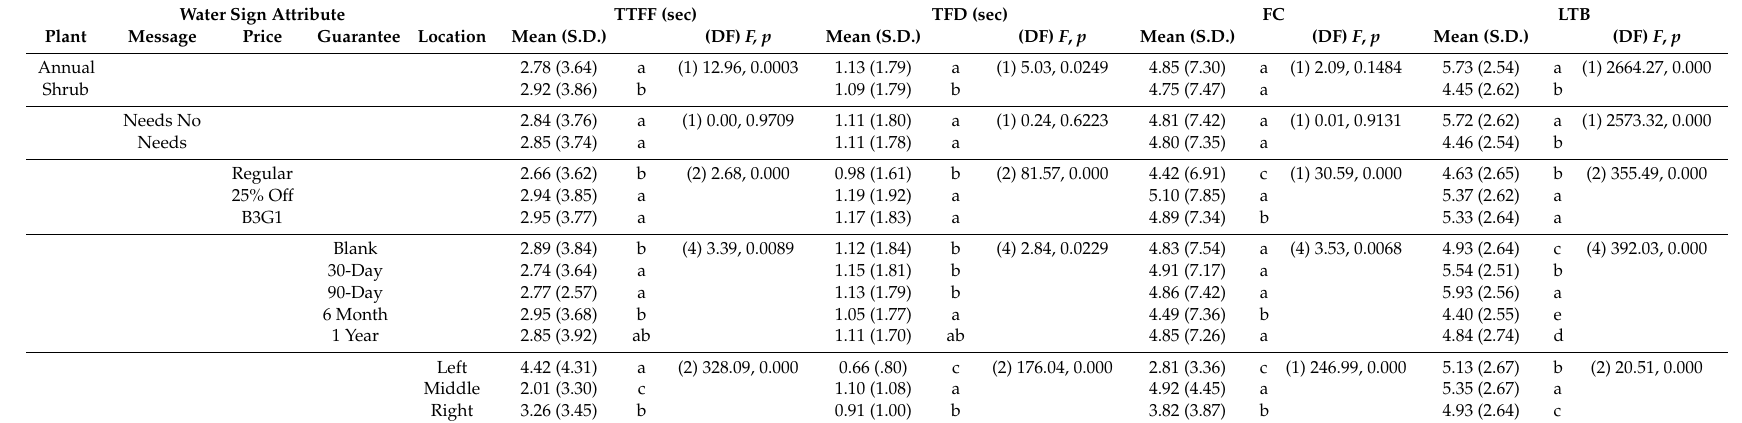
Table 4. Eye-tracking attributes by conjoint attribute levels 1